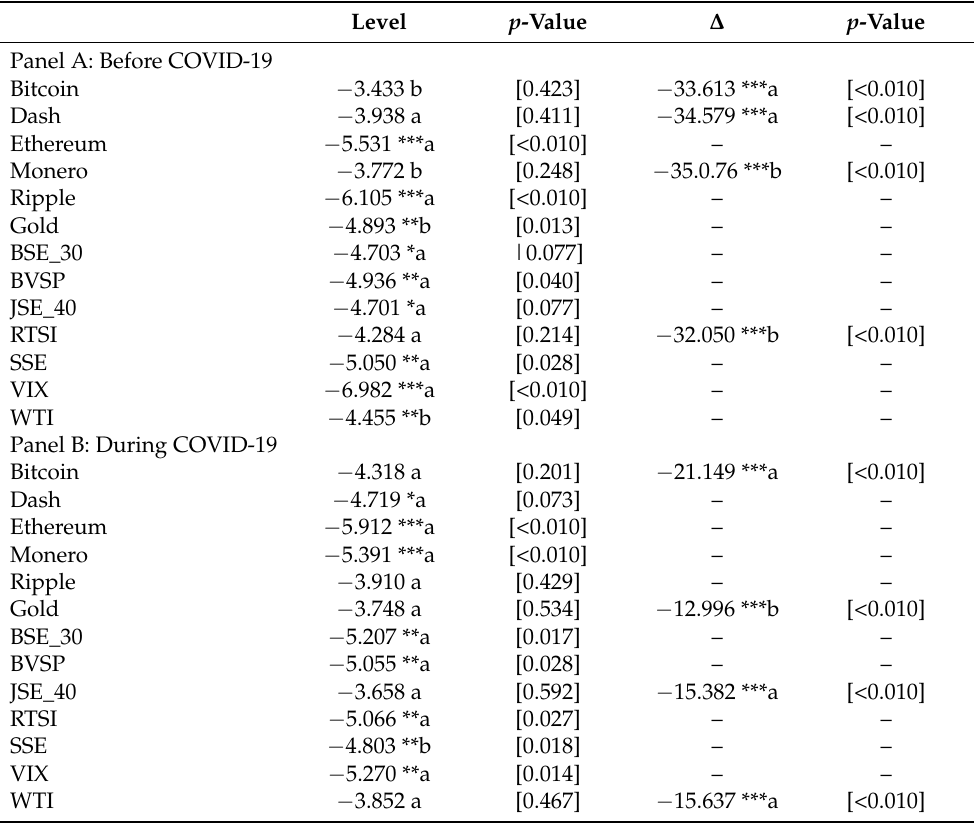
Table 3. Breakpoint unit root test.